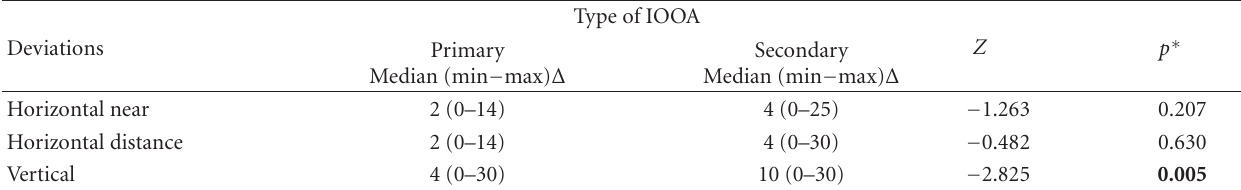
Table 3: The amount of change in deviations after the inferior oblique muscle weakening